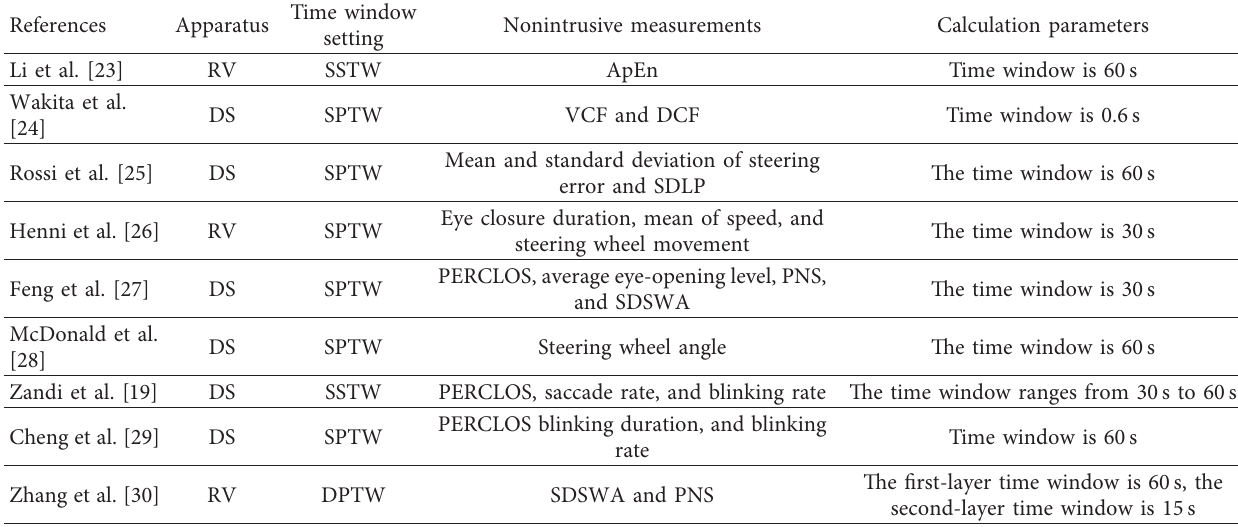
Table 1: Summary of information in drowsy driving